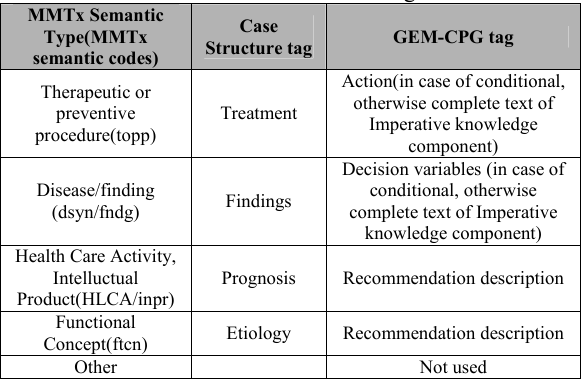
Table 3: Relationship between MMTx Semantic